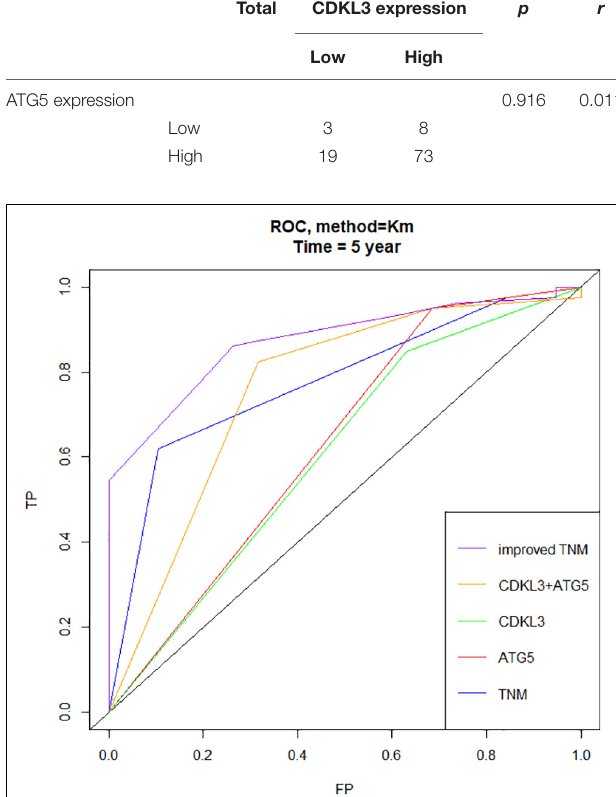
FIGURE 8 | Time-dependent ROC curves showed that the combination of CDKL3, ATG5 and TNM stage–based model (named as improved TNM) had better predictive accuracy than TNM stage in ESCC patients (FP, false positive or specificity, TP, true positive or